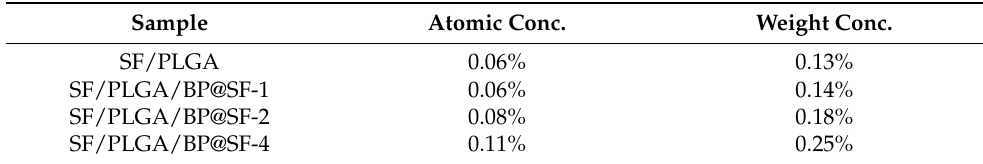
Table 1. P elemental analysis of electrospun membranes.